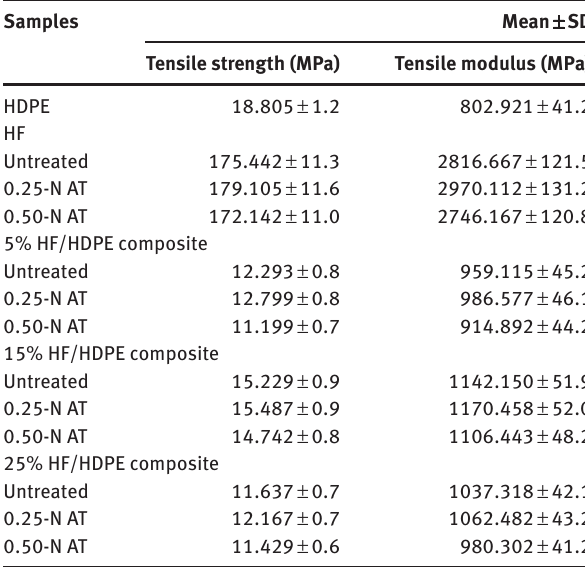
Table 3: Tensile test of HF and HF/HDPE composite.